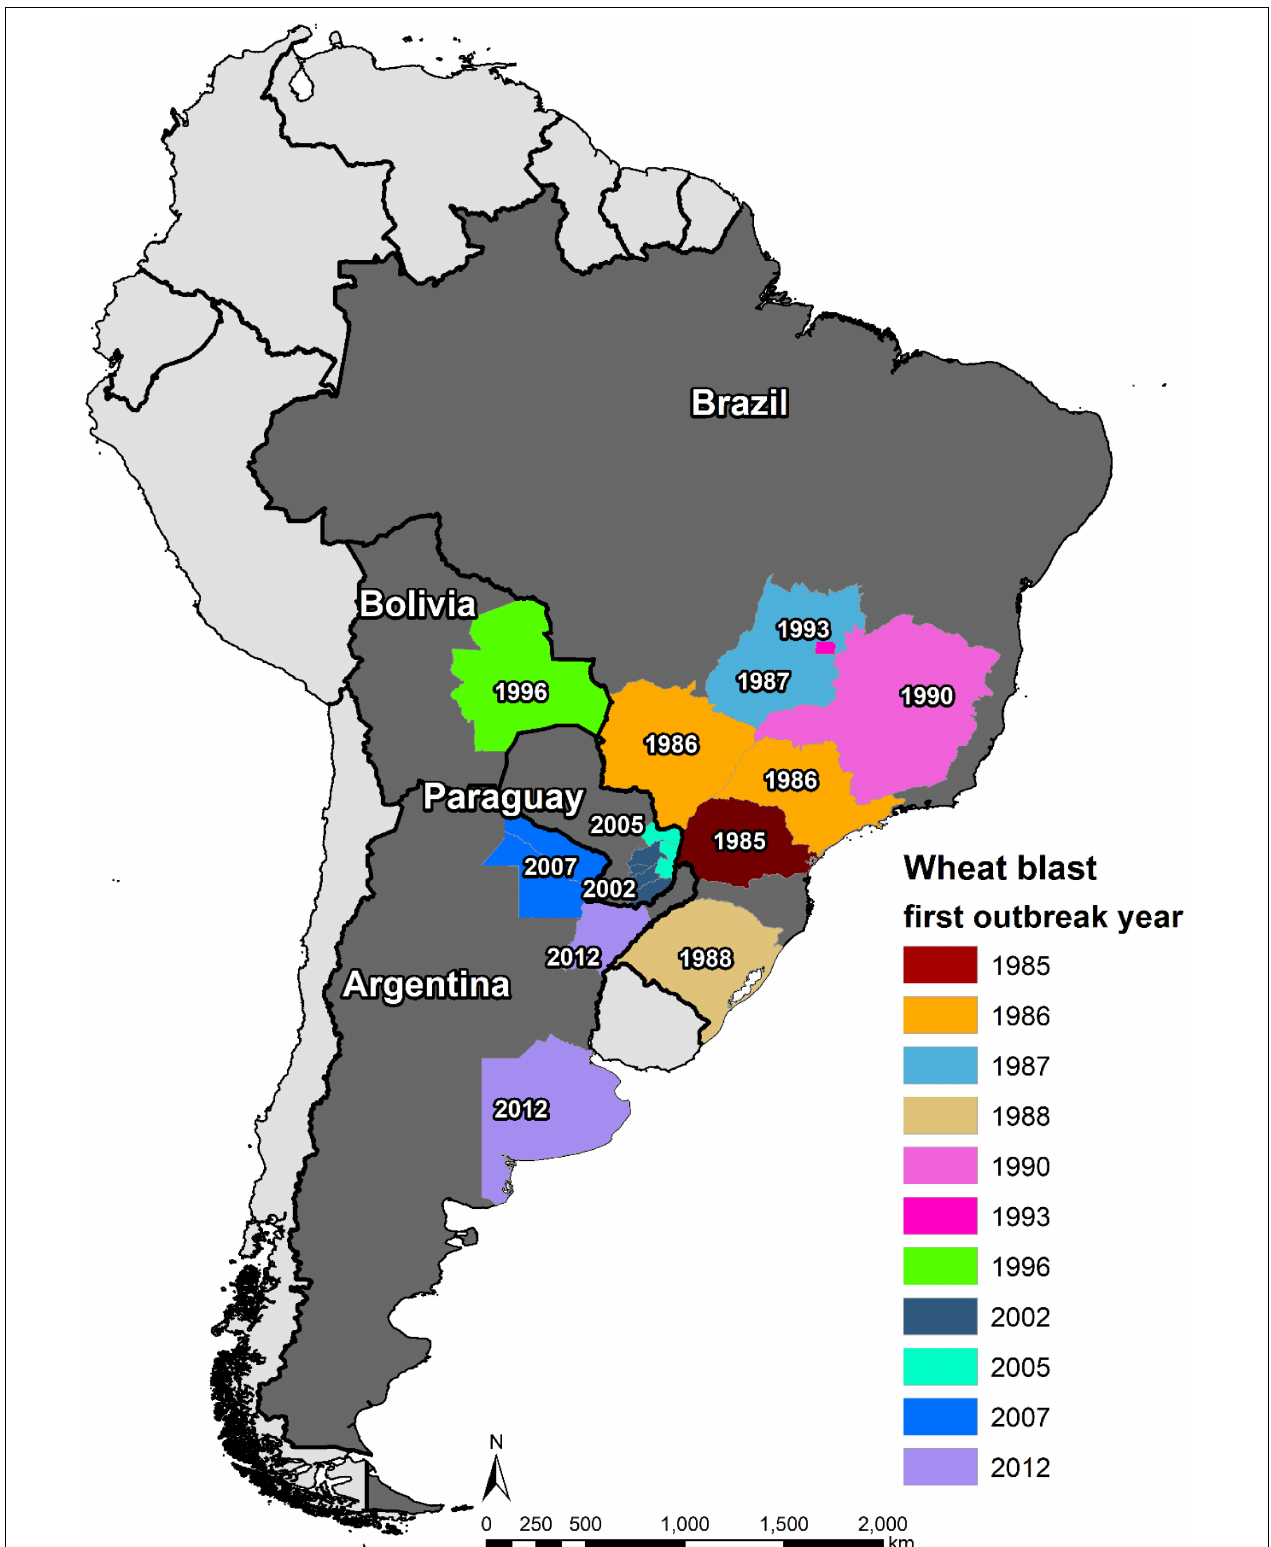
FIGURE 4 | Spread of wheat blast in South America from 1985 to